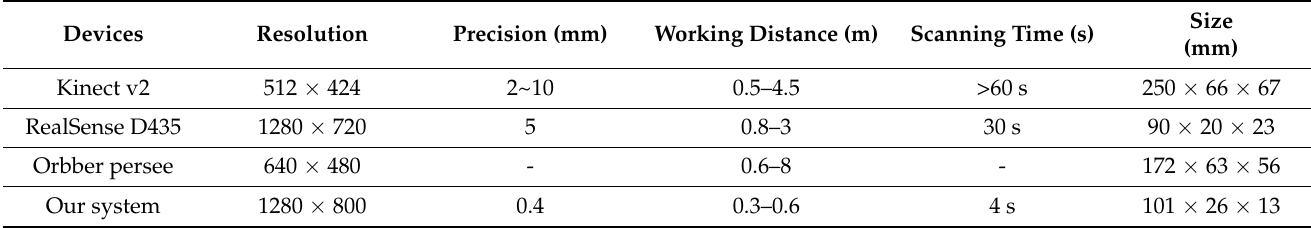
Table 1. The technical parameters of several 3D scanning systems.